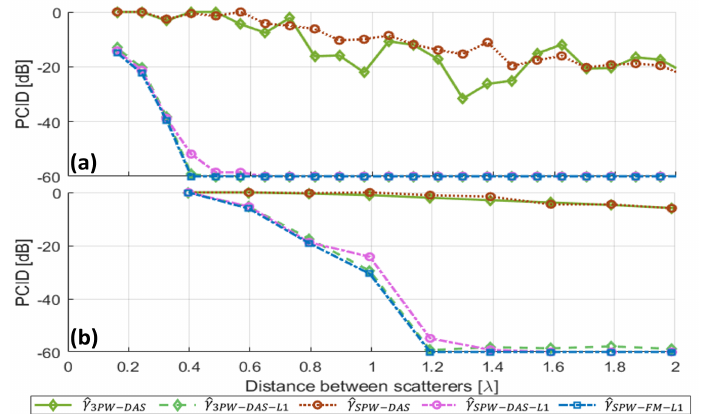
Figure 7. PCID measured on all reconsructed images. ( a ) Axial direction. ( b ) Lateral direction. The successive acquisitions (3PW), ˆ γ 3PW-DAS and ˆ γ 3PW-DAS-L1 , are displayed in green (solid line and dash-dotted line, diamonds). The simultaneous acquisitions, ˆ γ SPW-DAS , ˆ γ SPW-DAS-L1 , and ˆ γ SPW-FM-L1 , are displayed as follows: ˆ γ SPW-DAS is displayed in red, dotted line, circle; ˆ γ SPW-DAS-L1 is displayed in pink, dash-dotted line, circle; the proposed method ˆ γ SPW-DAS is displayed in blue, dash − dotted line, square. For the sake of clarity, the values of the peak − to − center intensity differences lower than this limit are shown at − 60 dB.